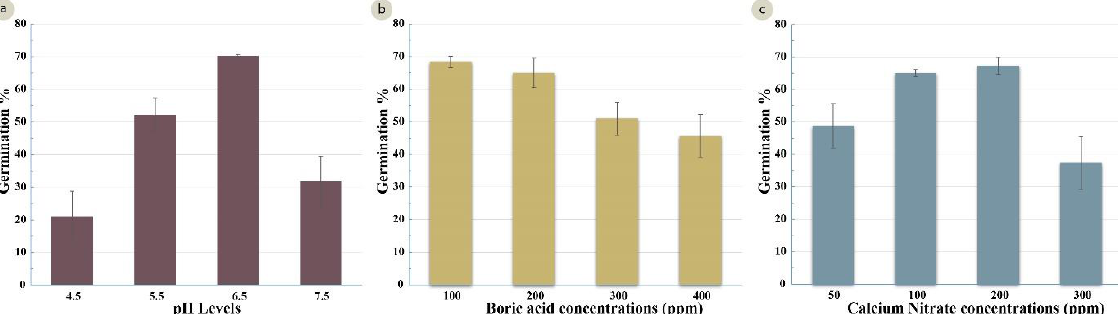
Figure 4. Effect of several factors on germination (%) of the wheat cultivar Gladius+Sr50. ( a ) different levels of pH (LSD 0.05 = 8.49%); ( b ) different concentrations of boric acid in mg/L (LSD 0.05 = 6.81%); ( c ) different concentrations of calcium nitrate in mg/L (LSD 0.05 = 7.76%). Error bars represent SE of the means.